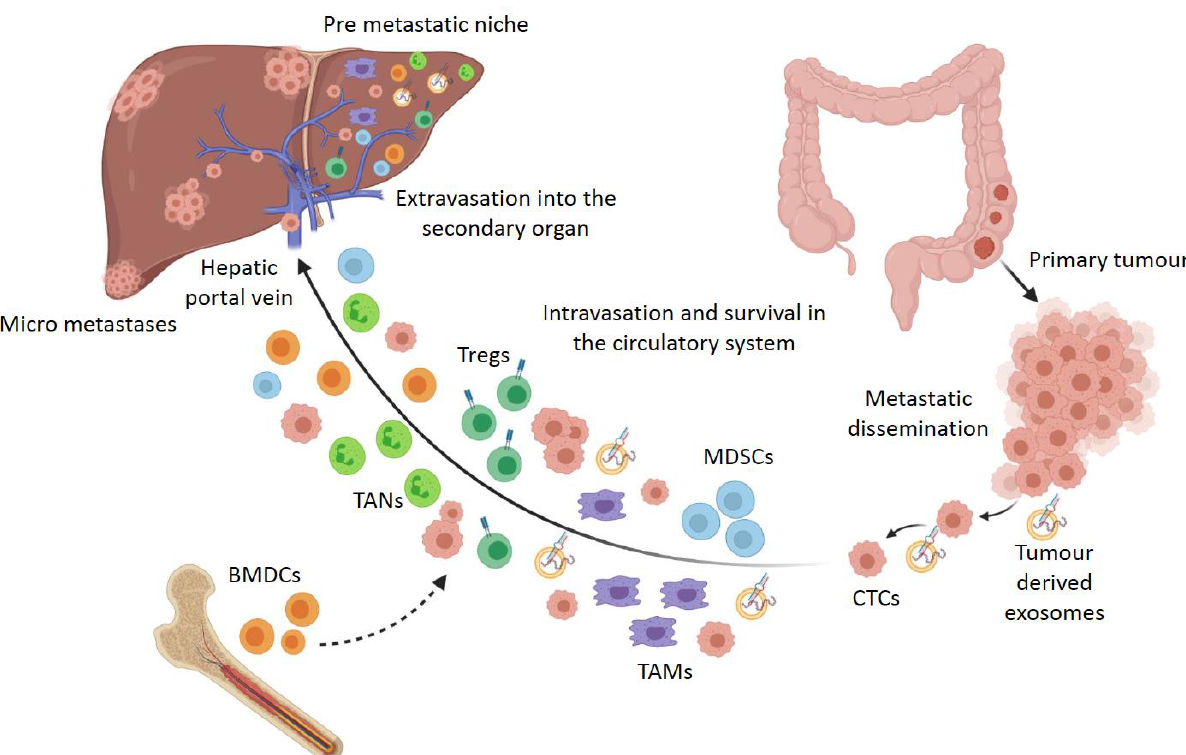
Figure 1. The metastatic cascade in colorectal cancer: fate of circulating tumour cells and components of the pre-metastatic niche. Disseminated cancer cells from the primary tumour travel through the circulation and enter the liver via the hepatic portal vein along with tumour derived factors, bone marrow-derived dendritic cells (BMDCs), and immune cells that prime the liver microenvironment for the colonisation of circulating tumour cells (CTCs) into micro-metastases. Tumour cells in different stages of EMT are localised in different microenvironments and interact with diverse subpopulations of stromal cells, contributing to their heteroge- neity. In colon cancer cells undergoing metastasis, the expression of transcription factors